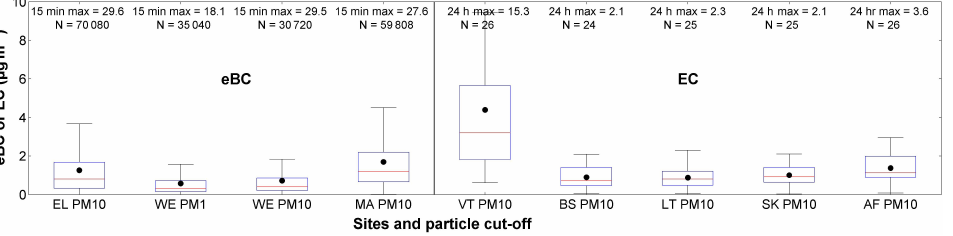
Figure 4. Box-and-whisker plot indicating statistical eBC mass concentrations at the Elandsfontein (EL), Welgegund (WE) and Marikana (MA) sites, as well as EC mass concentrations at the Vaal Triangle (VT), Botsalano (BS), Louis Trichardt (LT), Skukuza (SK) and Amersfoort (AF) sites. The red line of each box indicates the median, the black dot the mean, the top and bottom edges of the box the 25th and 75th percentiles and the whiskers ± 2.7 σ (99.3% coverage if the data have a normal distribution). The 15min and 24h maximum mass concentration values measured at the sites with continuous and offline analyses, respectively, as well as the number of measurements ( N ), are